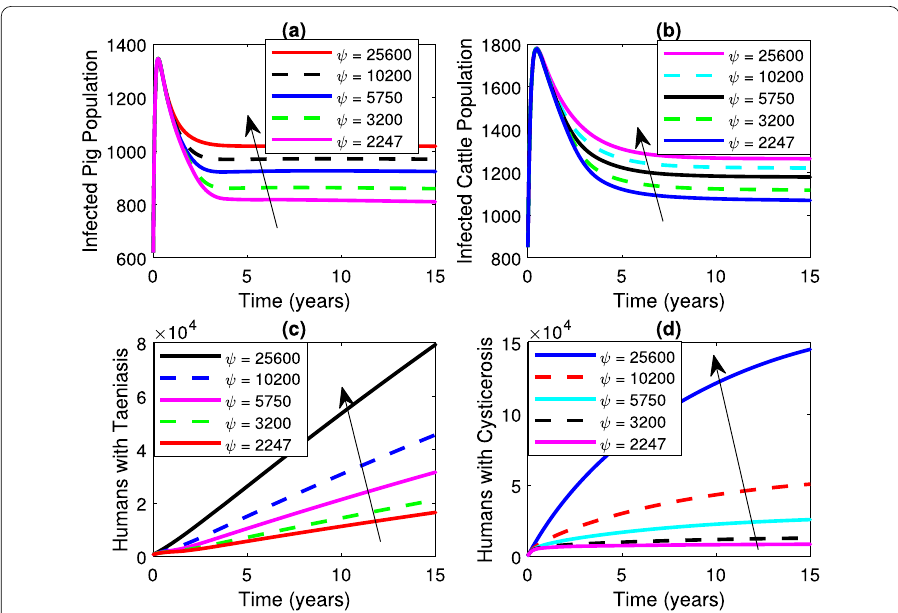
Figure 4 Impact of varying human recruitment rate on infected populations